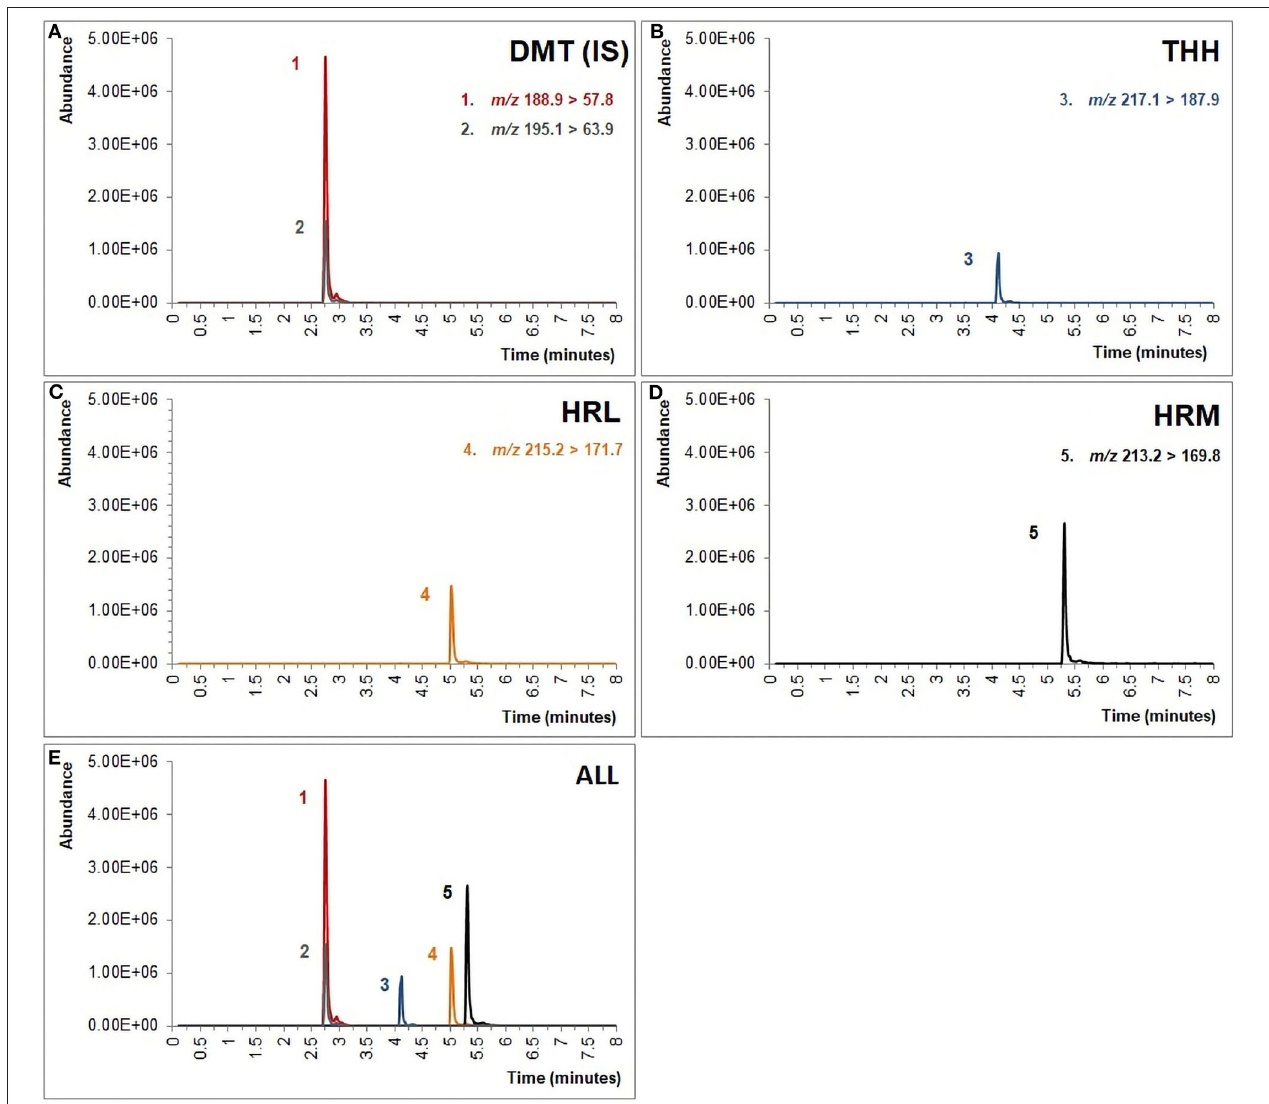
FIGURE 1 | Chromatogram obtained from a fortified urine sample containing 100ng/ml of (A) dimethyltryptamine (DMT) and internal standard (IS, DMT- d 6 ), (B) tetrahydroharmine (THH), (C) harmaline (HRL), and (D) harmine (HRM). (E) All analytes are displayed together. The m/z showed above were used for quantification of the